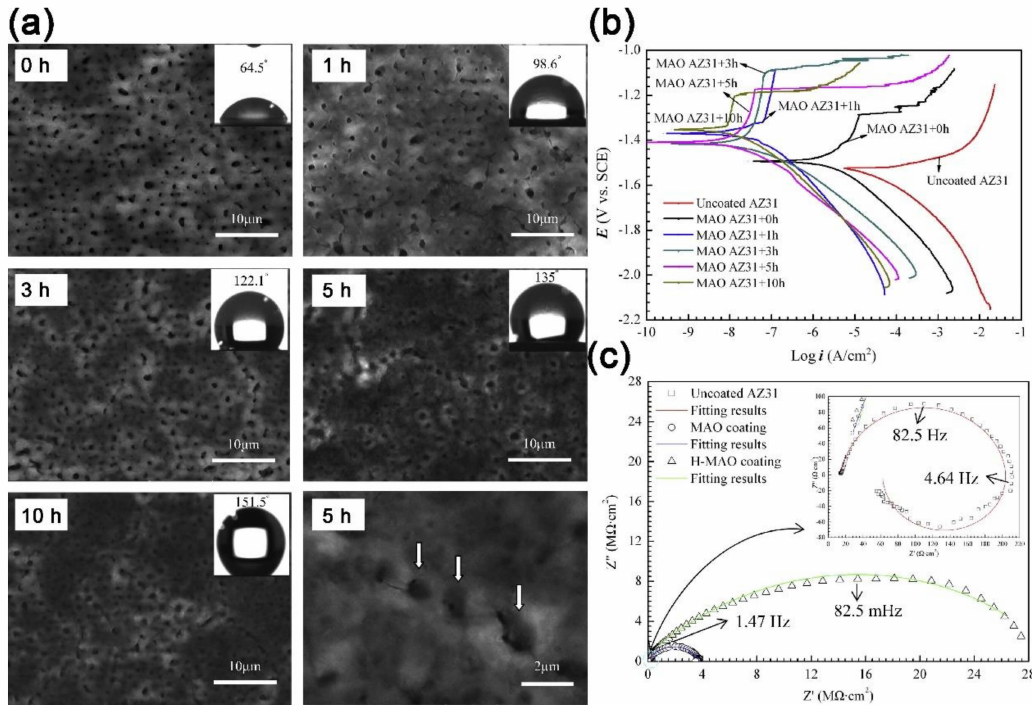
Figure 9. ( a ) Surface morphologies and inserted corresponding contact angles of the MAO coatings modified for 0, 1, 3, 5, and 10 h; ( b ) Potentiodynamic polarization curves of bare AZ31 Mg alloy and MAO coatings modified for di ff erent times; ( c ) EIS results and fitting curves for uncoated AZ31 Mg alloy, MAO coating, and H-MAO coating in 3.5 wt % NaCl solution. Reprinted from [74], Copyright (2015), with permission from